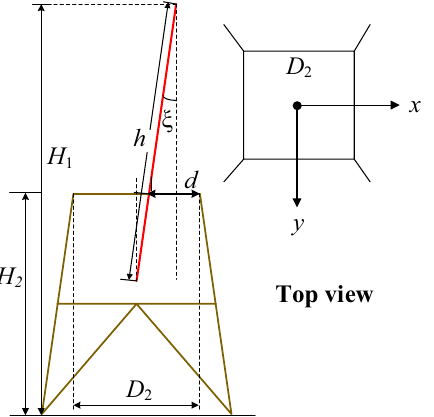
Figure 4. The calculation of the distance between the holding derrick and steel